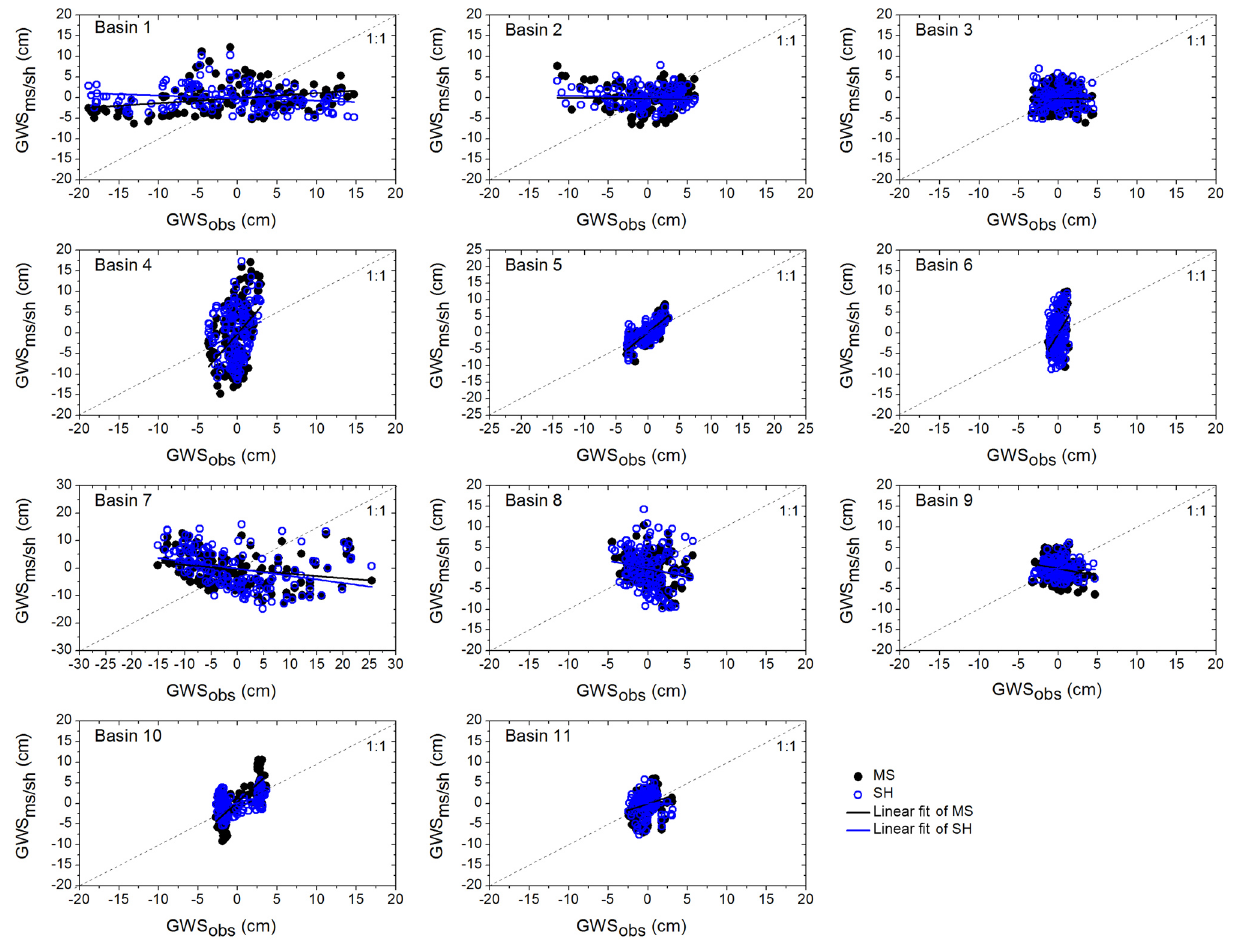
Figure 6. Basin-wide scatter analysis of in situ GWSA with the GWSA obtained using the GRACE mascon product (MS, black filled circles) and GRACE SH products (SH, blue open